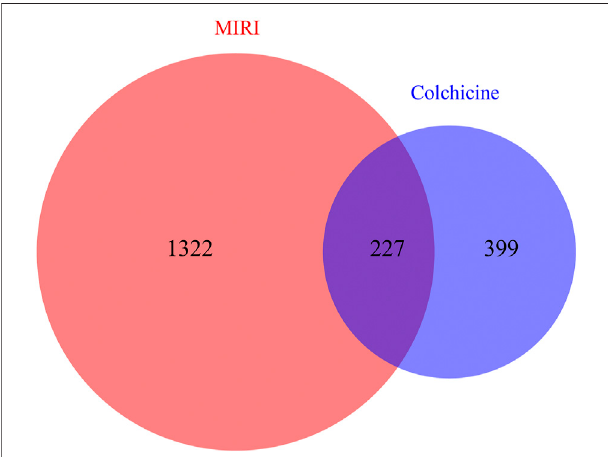
FIGURE 3 | Venn diagrams showing the number of shared and unique targets by Colchicine and MIRI were represented. A total of 227 targets of colchicine with therapeutic potential for MIRI were identi fi